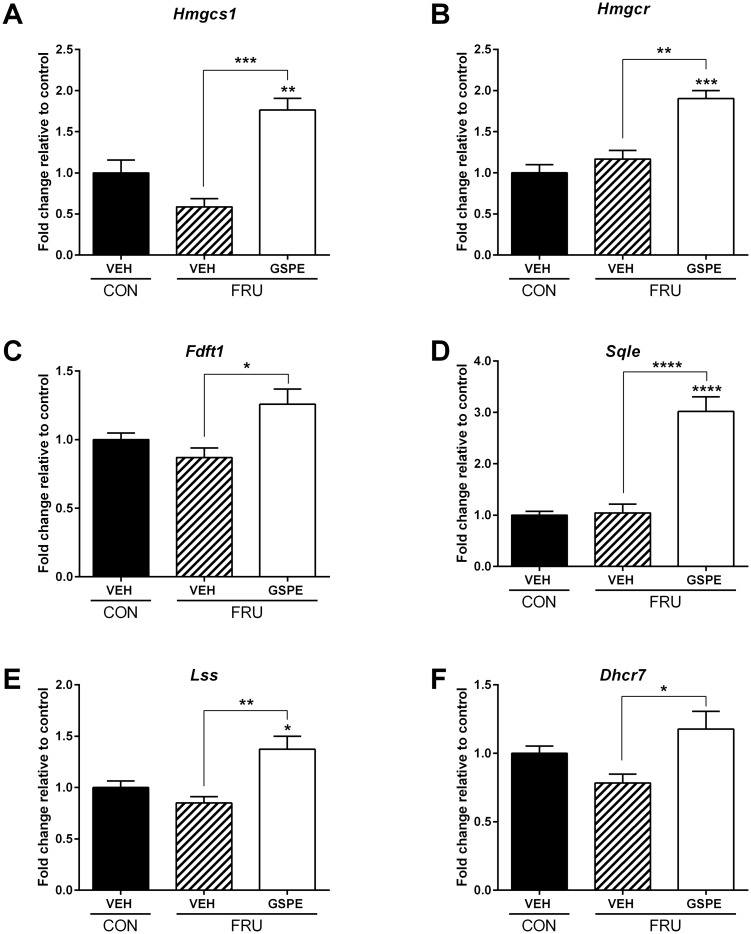
Hepatic expression of genes involved in cholesterol synthesis following treatments.Gene expression changes were analyzed for (A) Hmgcs1, (B) Hmgcr, (C) Fdft1, (D) Sqle, (E) Lss, and (F) Dhcr7. *p<0.05, **p<0.01, ***p<0.001 and ****p<0.0001.